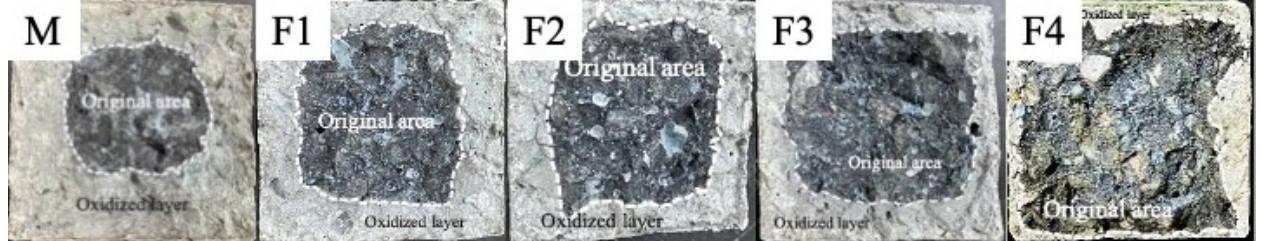
Figure 2. Photographs of the cross-section of the fired castables without micronized andalusite (M) and with 1 wt% (F1), 2 wt% (F2), 3 wt% (F3), and 5 wt% (F4) micronized andalusite after thermal shock tests.